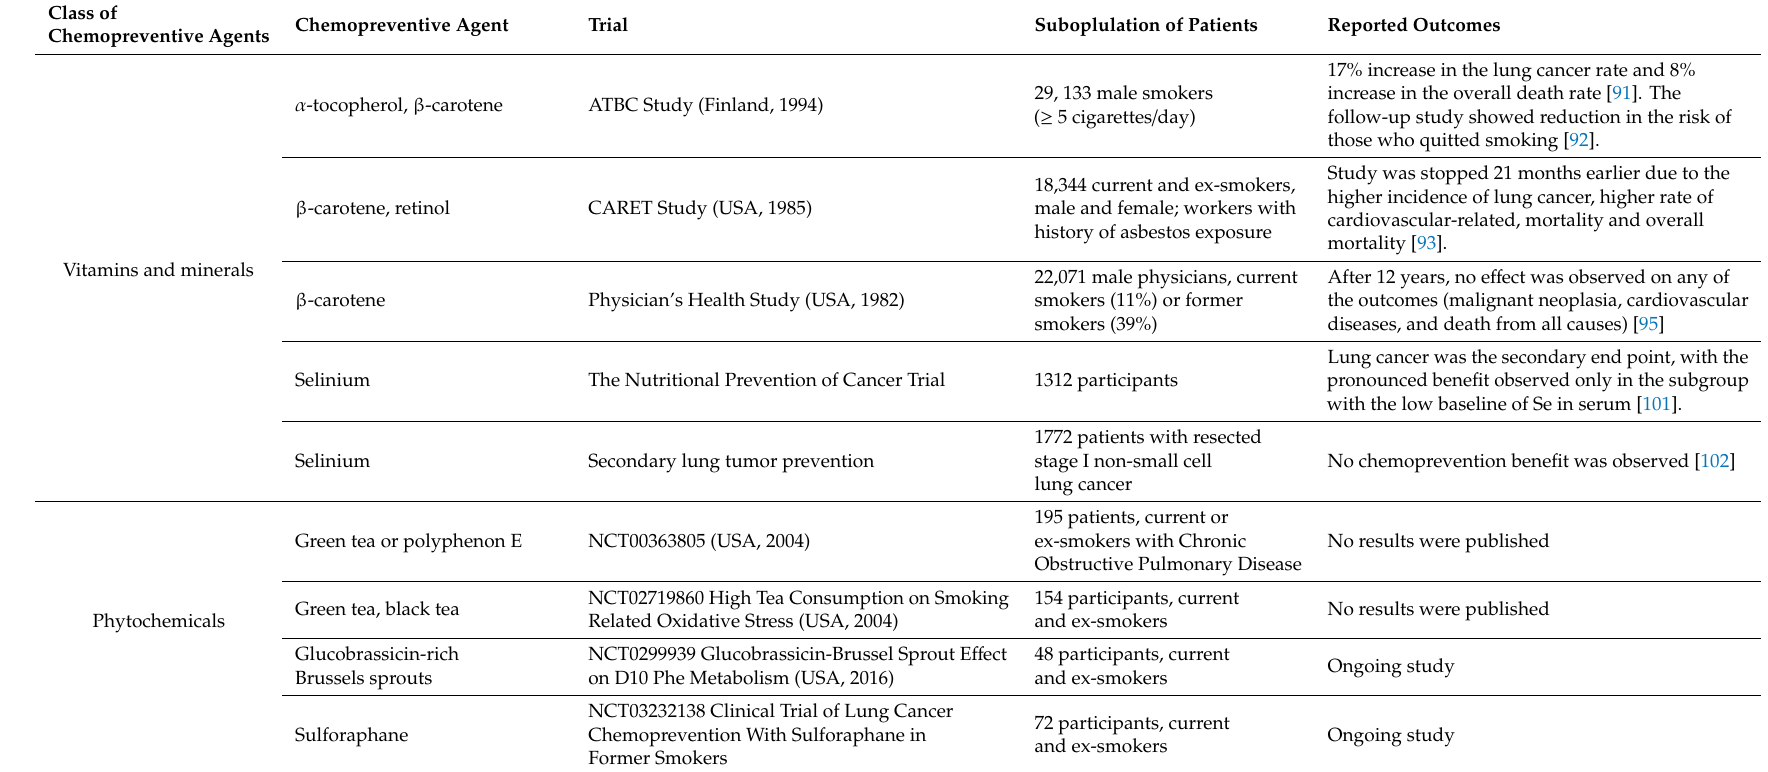
Table 2. List of selected lung cancer chemoprevention trials listed in the